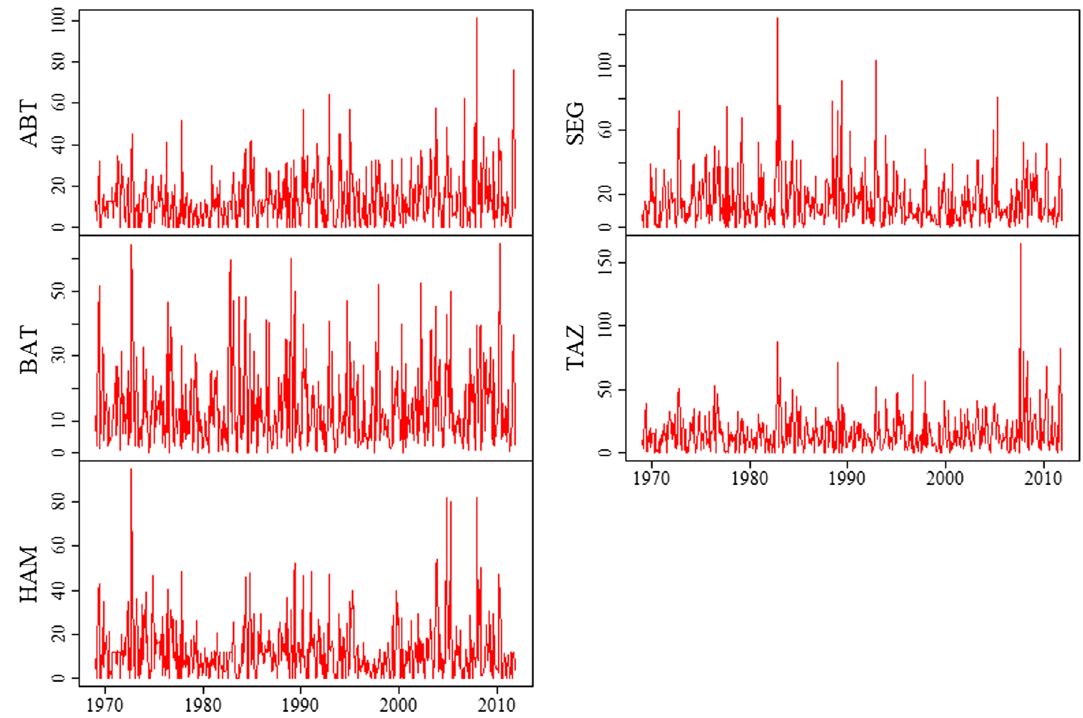
Fig. 3 Graphical presentation of the annual maximum precipitation for each station